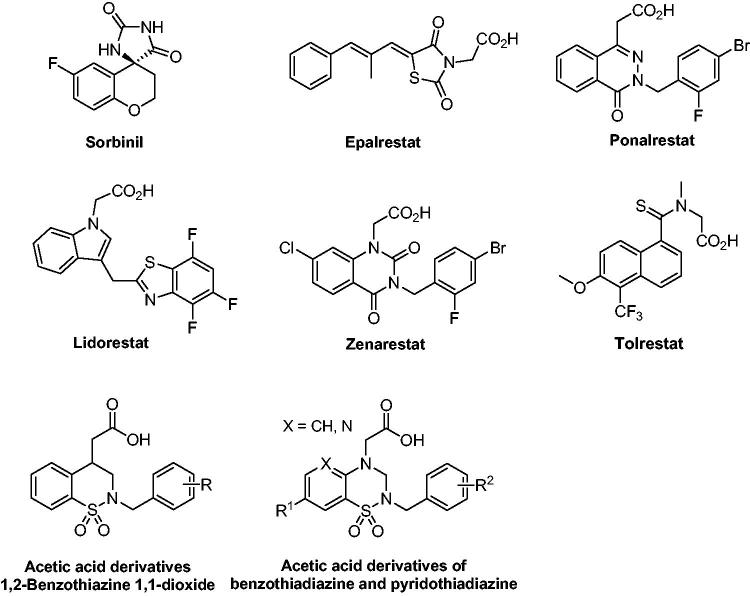
Structures of ARIs.